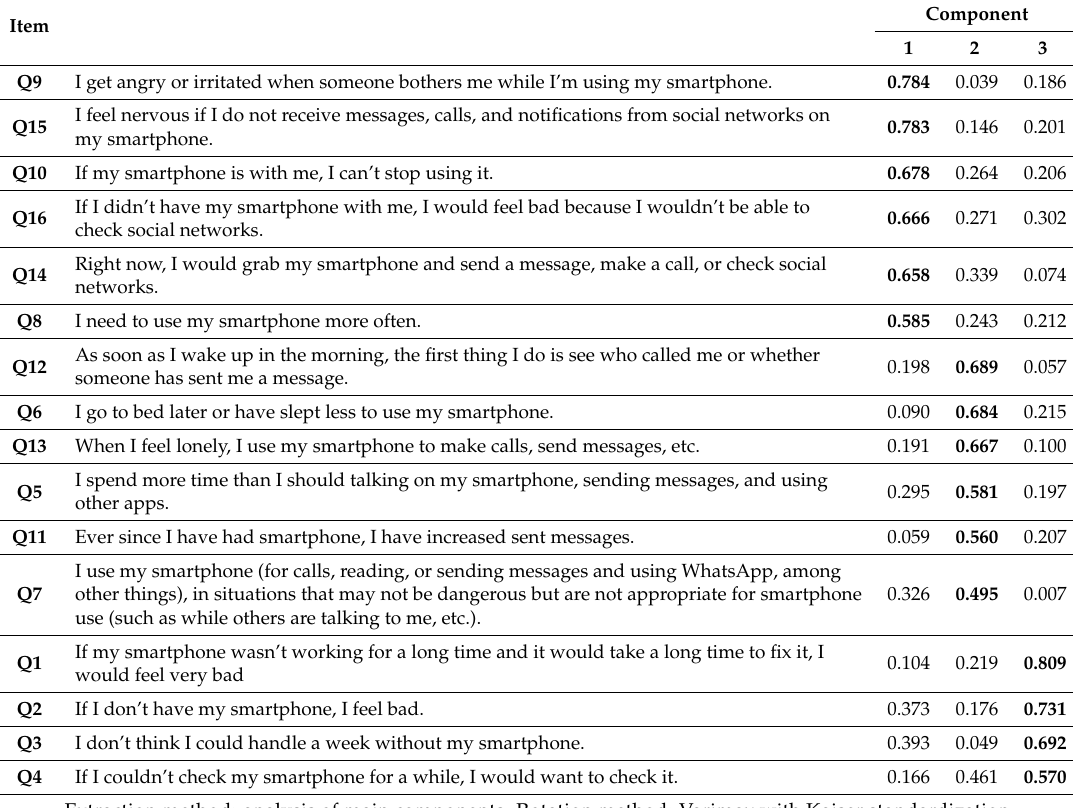
Table 10. Rotated component matrix and its associated